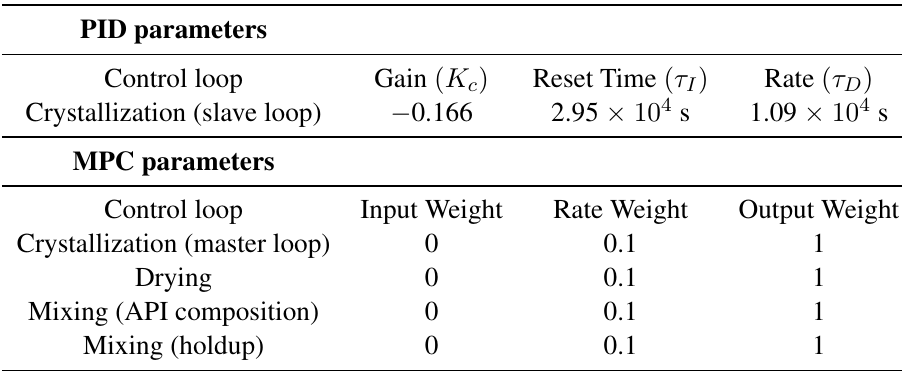
Table 2. List of controller tuning parameters.